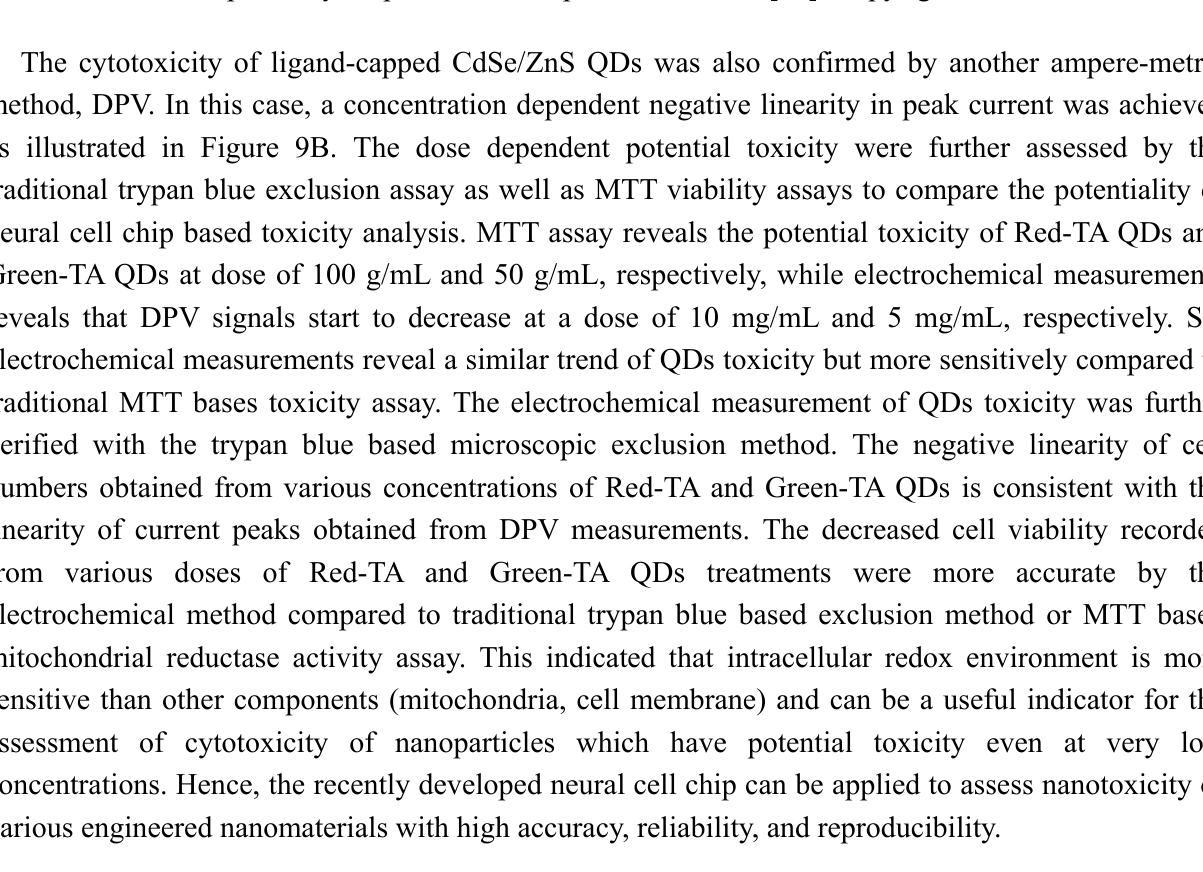
Figure 8. Schematics for the detection of cytotoxicity of thioglycolic acid (TA) or cysteamine (CA)-capped green and red quantum dots (QDs) based on cell chip and conventional MTT assay. “R”, “W” and “C” mean the reference, working, and counter electrodes, respectively. Reproduced with permission from [29], Copyright 2012,